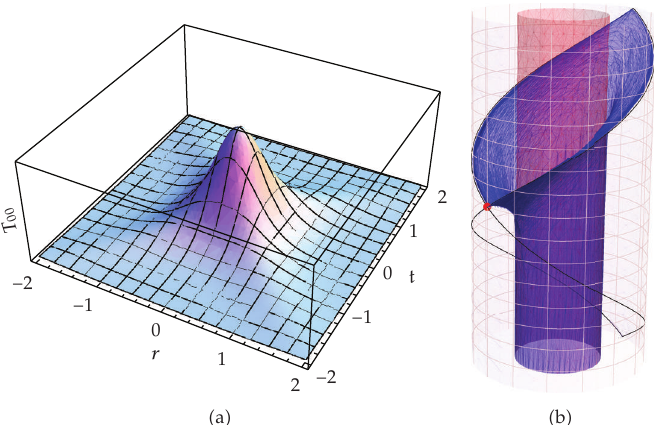
Figure 5: Conformal soliton energy density (cid:3) a (cid:4) and dual geometry (cid:3) b (cid:4) . On the left, T 00 (cid:3) t,r (cid:4) is plotted as a function of boundary time t and boundary radial variable r . On the right, the outer cylinder represents the AdS boundary, the inner (cid:3) red (cid:4) cylinder corresponds to the global Schwarzschild-AdS event horizon, which coincides with the apparent horizon of the conformal soliton, whereas the flared (cid:3) blue (cid:4) surface is the actual event